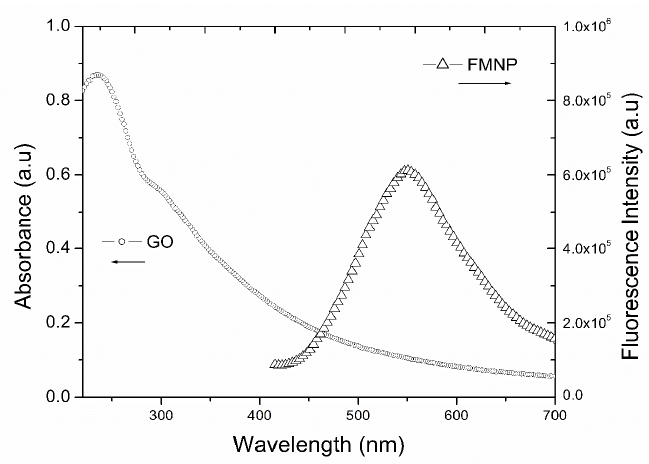
Figure 5. Photoluminescence of FMNPs with the excitation wavelength.